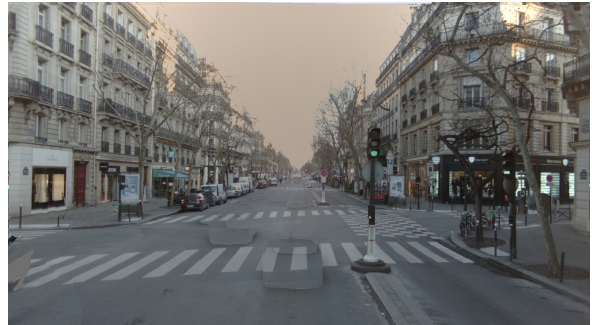
Figure 5: Projective multi-texturing (8 simultaneous textures). Note how the holes due to filtered-out vehicles and pedestri- ans are filled-in using neighboring images. Shadow artifacts are present around the removed cars which may be addressed, as a future work, by enlarging the masks to also include the shadows or by using a gradient-based image fusion (P´erez et al., 2003).